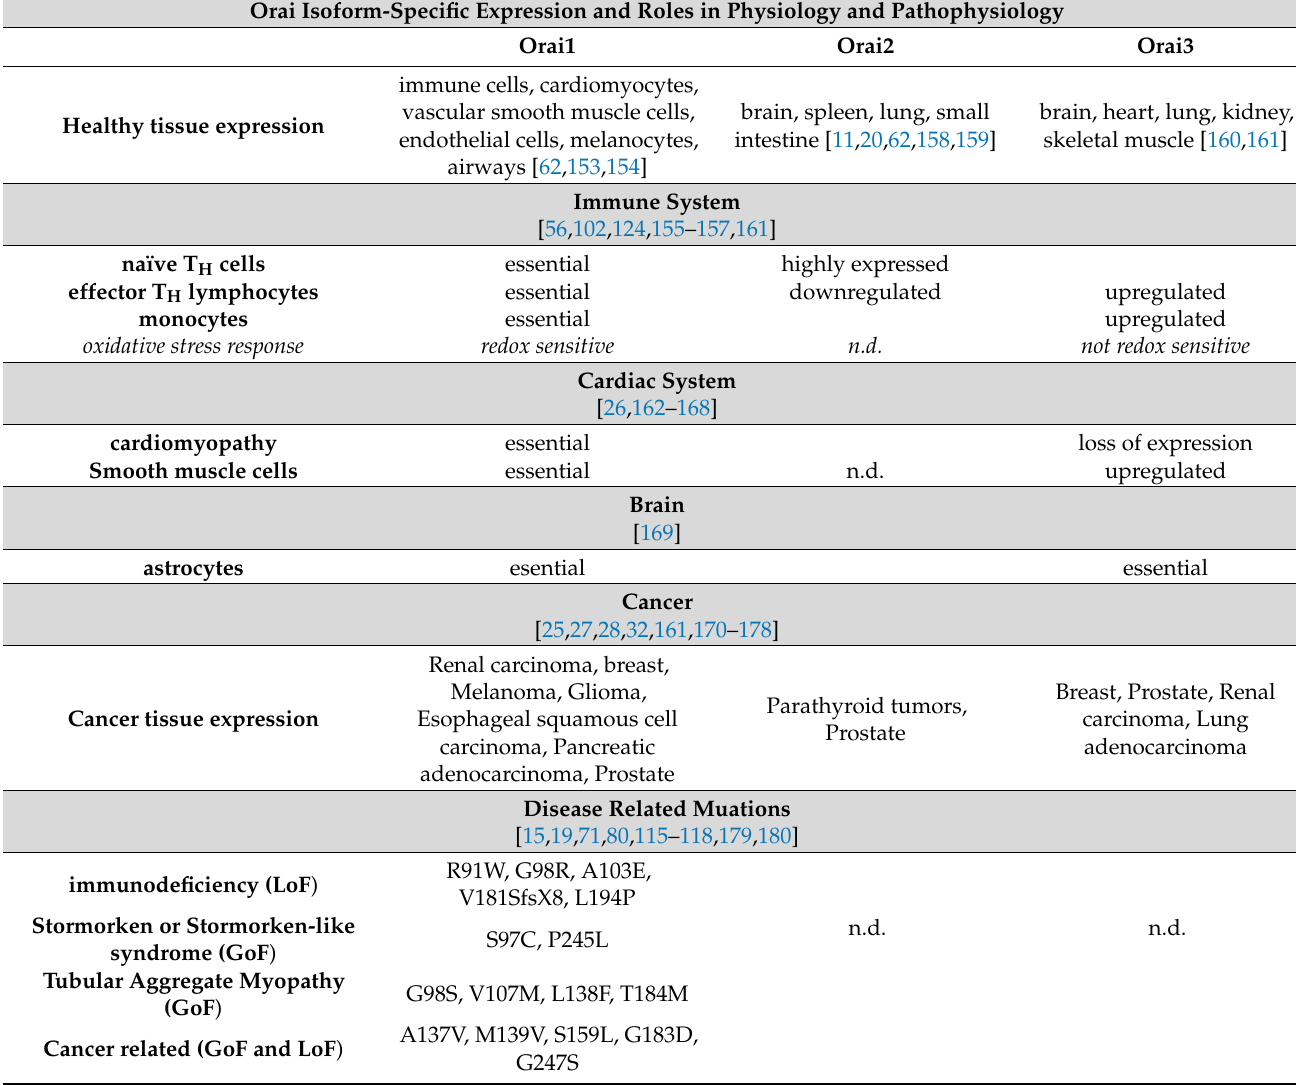
Table 6. The expression and pathophysiological relevance of Orai isoforms. Orai Isoform-Specific Expression and Roles in Physiology and Pathophysiology Orai1 immune cells,